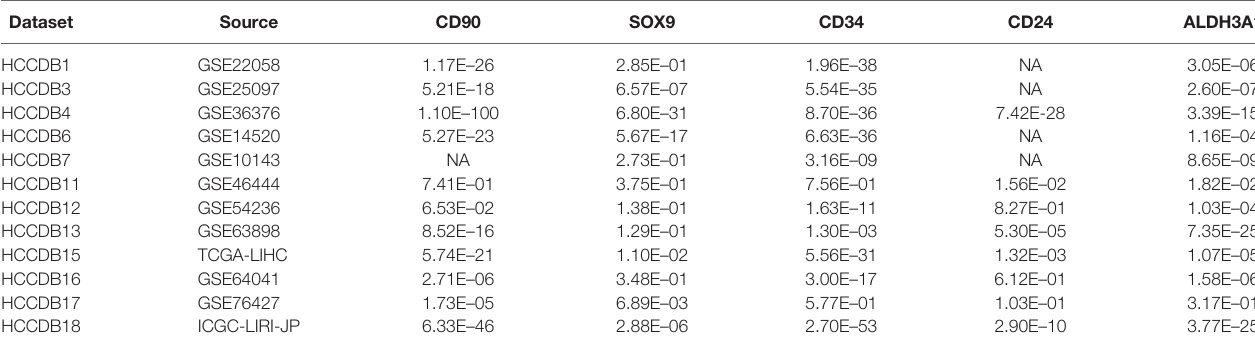
TABLE 1 | P value of the fi ve increased HCSC markers in HCCDB